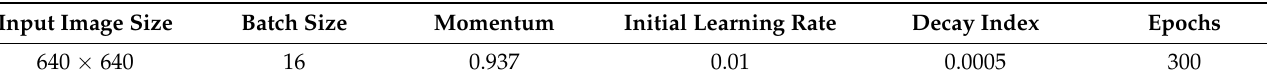
Figure 8. YOLOv5-CB network structure. Table 2. Training